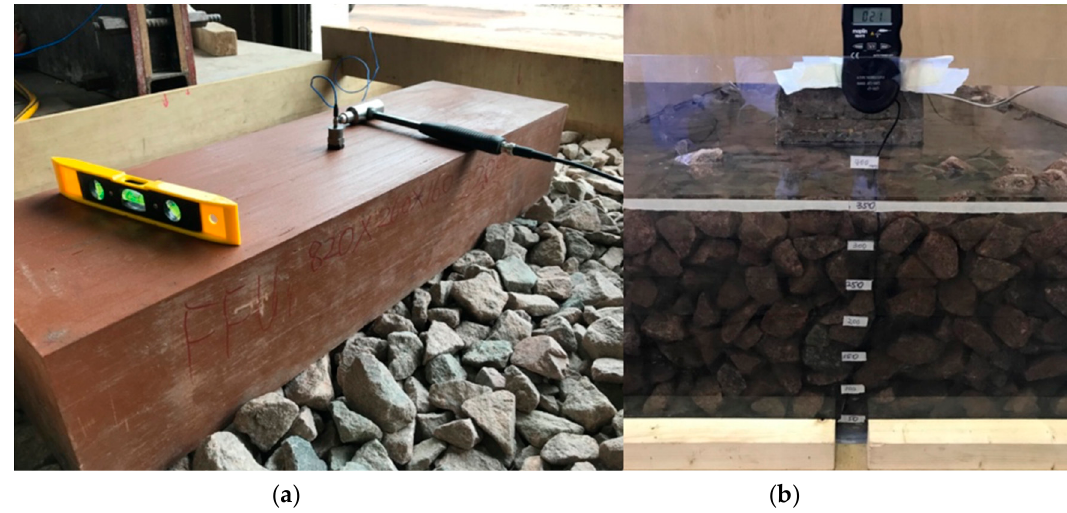
Figure 6. ( a ) Level for adjusting the surface of testing mass; ( b ) thermometers for recording the testing temperature at di ff erent water